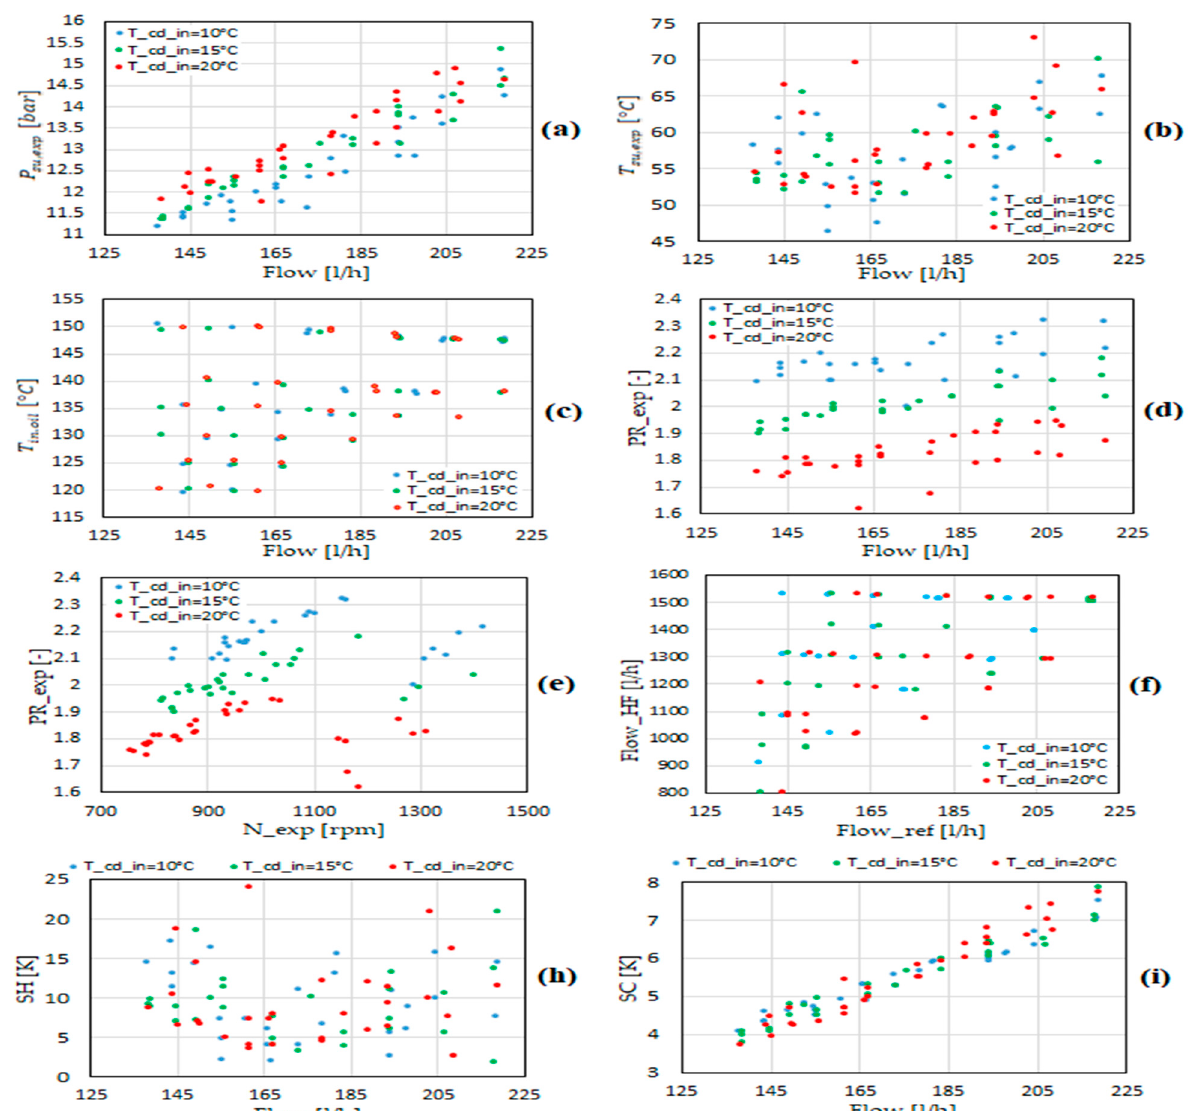
Figure 2. Range of the parameters constituting the experimental database: expander suction pressure vs flow rate ( a ), expander suction temperature vs flow rate ( b ), hot fluid inlet temperature to the evaporator vs flow rate ( c ), expander pressure ratio vs flow rate ( d ), expander pressure ratio vs expander shaft speed ( e ), hot fluid flow rate vs refrigerant flow rate in the evaporator ( f ), superheating degree vs refrigerant flow rate in the evaporator ( h ), and subcooling degree vs. refrigerant flow rate in the condenser ( i ).